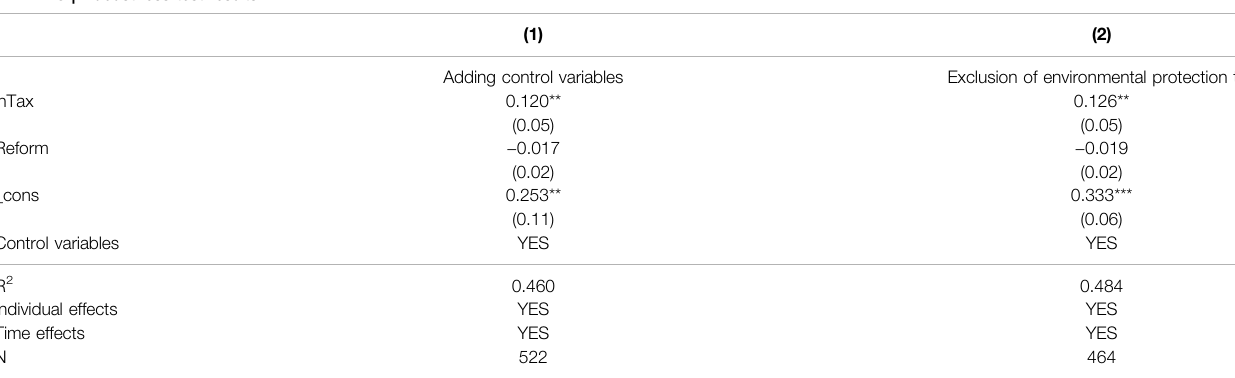
TABLE 8 | Robustness test